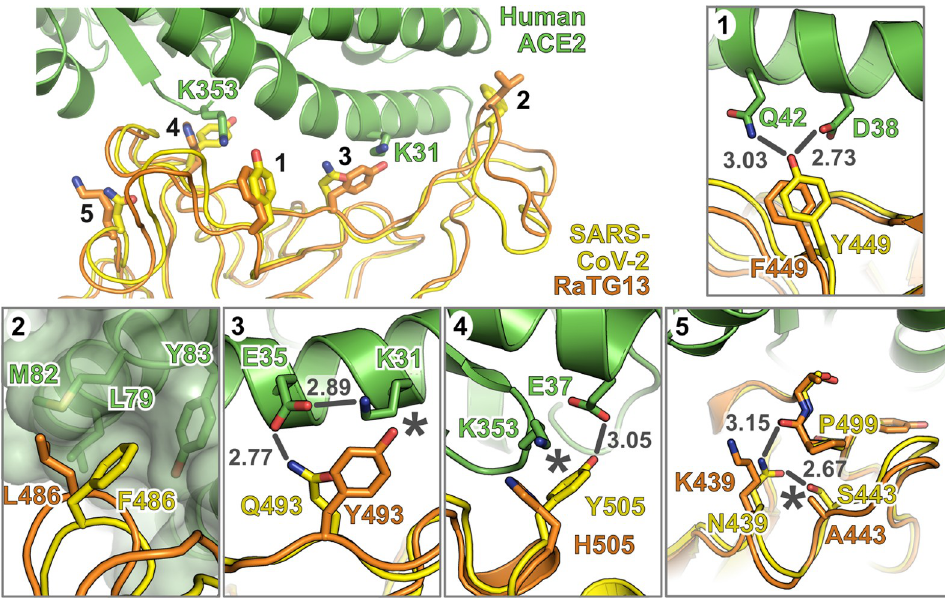
Fig 6. Amino acid variation in SARS-CoV-2 and RaTG13 RBD impacts human ACE2 receptor utilisation. Structure of RaTG13 RBD (orange) [12] superposed onto the structure of human ACE2 (green) in complex with the SARS-CoV-2 RBD (yellow) [10]. Selected RBD residues that promote association with ACE2 are highlighted, as are the ACE2 “hotspot” residues K31 and K353 [13]. Insets 1 to 5 show molecular interactions discussed in the main text. Bonds that may be disrupted are shown as grey lines, with bond distances in grey text, and hydrophobic interactions that may be disrupted or potential steric clashes are marked with asterisks. ACE2, angiotensin-converting enzyme 2; RBD, receptor binding domain; SARS-CoV-2, SARS Coronavirus